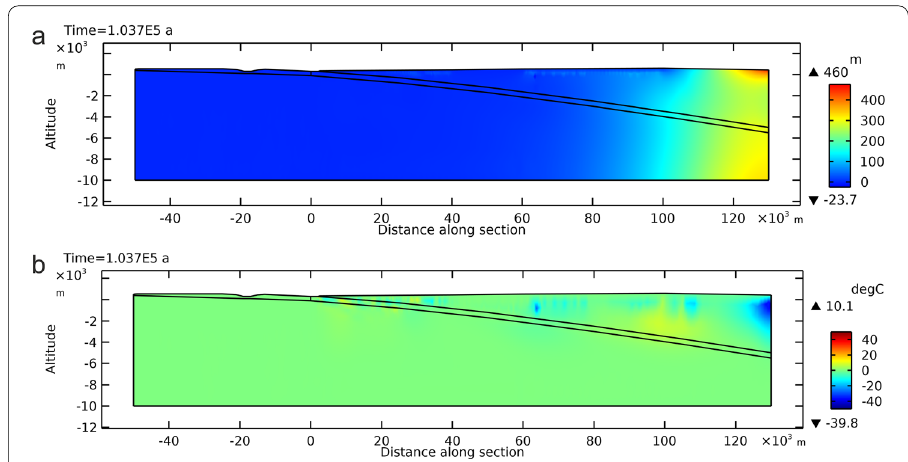
Fig. 10 Hydraulic and thermal effect of the Inn Glacier (i.e. difference between model runs E and C introduced in Fig. 3). a Hydraulic head difference and b temperature difference induced by the Inn Glacier at its maximum extent 26.3 ka ago (time 1.037E5 a) in the high Malm permeability scenario under = paleoclimatic conditions. Vertical exaggeration equals